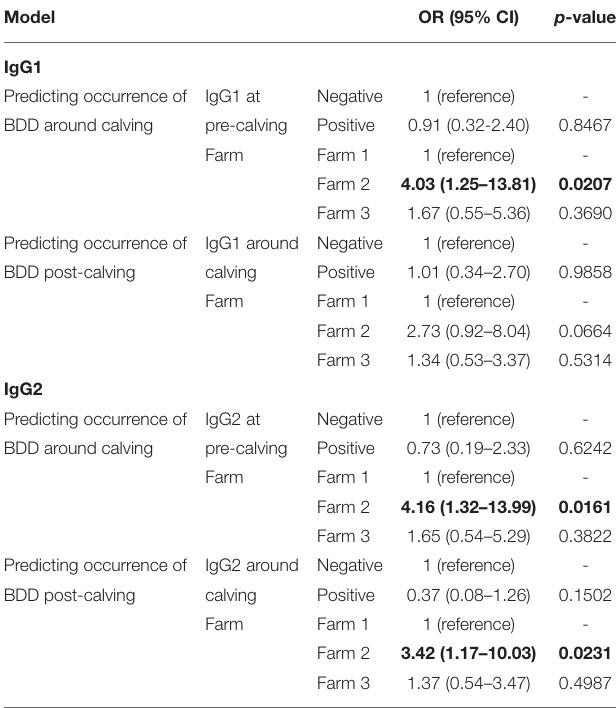
TABLE 10 | Results from the generalised linear models assessing the predictive power of ELISA test in the future occurrence of BDD